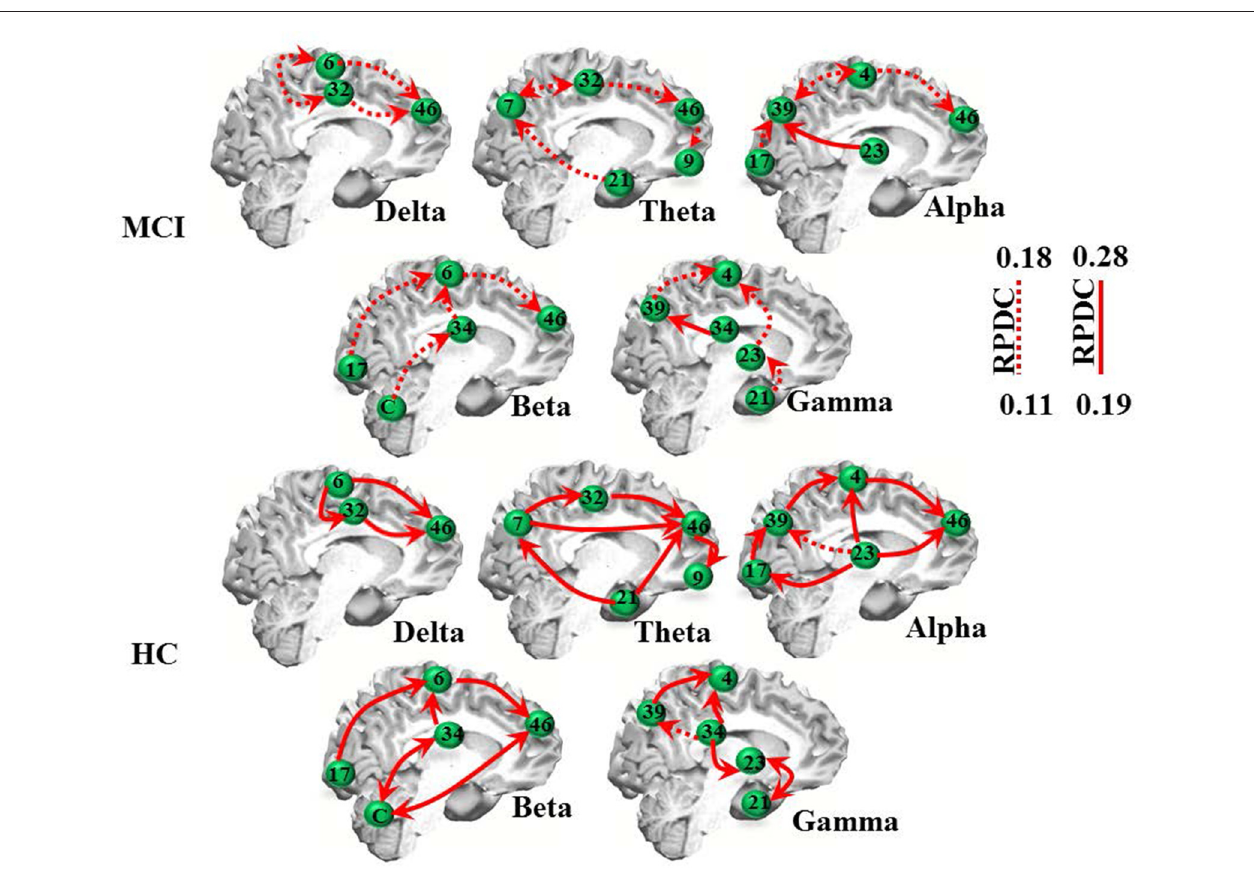
FIGURE 2 | EEG renormalized partial directed coherence (RPDC) results. Top two rows: RPDC for mild cognitive impairment (MCI) participants. Bottom two rows: RPDC for healthy controls (HC). RPDC ranges between 0 and 1, and can be unidirectional or bidirectional (visualized by two red arrows). The labels indicate Brodmann areas (BAs).